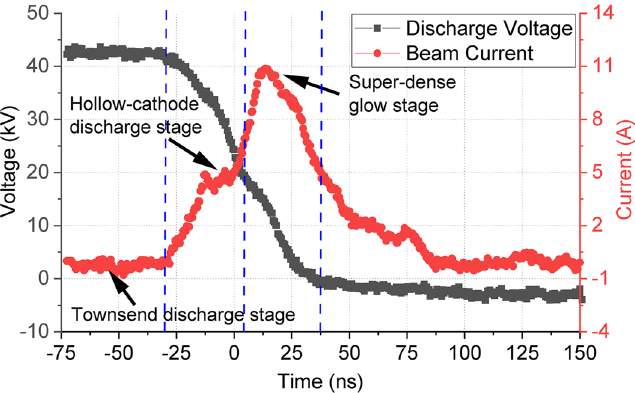
Figure 4. The correlated waveforms of the discharge voltage and the electron